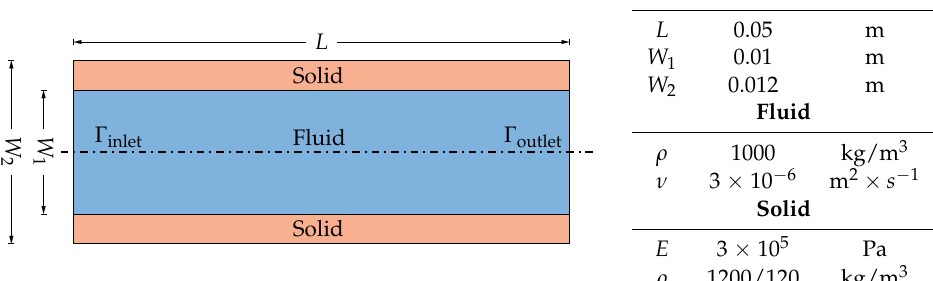
Figure 3. Domain geometry—not to scale—( left ) and dimension and material parameters ( right ) of the Elastic-Tube-3D test